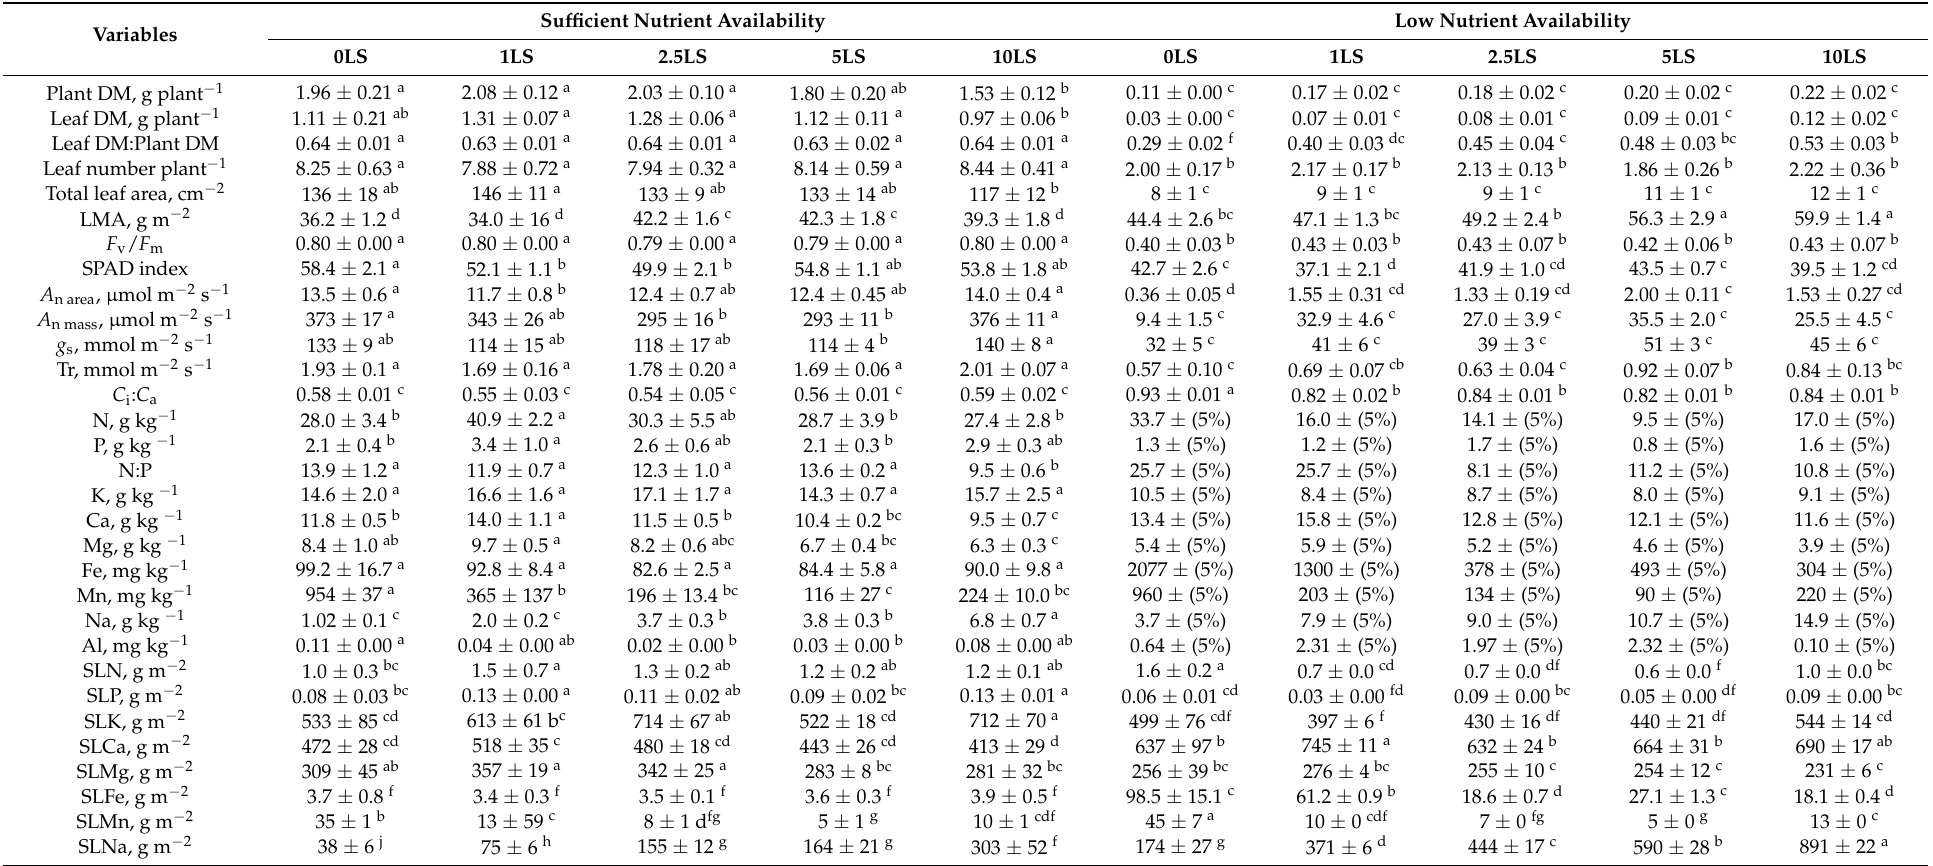
Table 3. Mean ( ± SE) values of physiological traits of cucumber seedlings grown on the soil substrates with lignosulfonate concentration of 0 (0LS), 1 (1LS), 2.5 (2.5LS), 5 (5LS), and 10 (10LS) % under sufficient or low nutrient